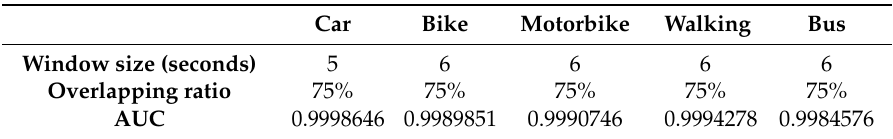
Table 7. Optimized parameters of